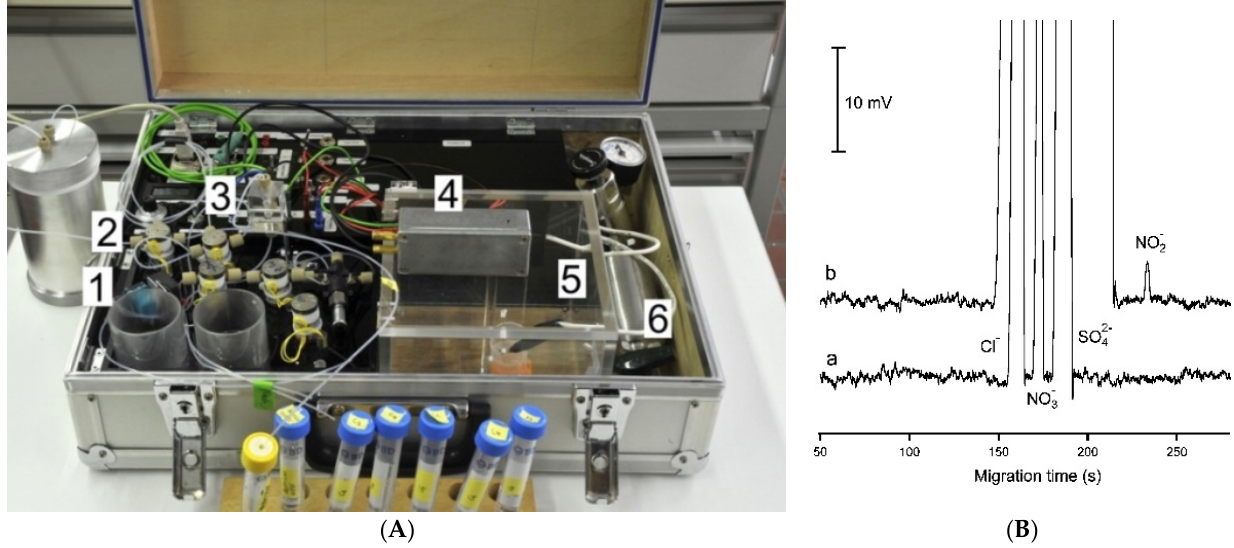
Figure 10. Photograph ( A ), and sample recording of an electropherogram applied in water analysis ( B ) of a laboratory-made portable capillary electrophoresis system with contactless conductivity detection [50]. In ( A ): (1) membrane pump, (2) valves, (3) splitter, (4) detector, (5) safety cage for application of high voltage, (6) pressurized air. In ( B ): recoding of the CE analysis of a tap water sample spiked with 1 µ M NO 2 − . (a) Normal injection volume: 1 bar, 150 µ L, splitting valve set to 0.15, 4 s. (b) Large volume injection: pressure, 1 bar; sample loop, 150 µ L; splitting valve set to 0.10; injection time, 10 s. CE conditions: capillary—60 (36) cm, 50 µ m I.D., BGE—12 mM His adjusted to pH 4 with AcOH, 2 mM of 18-crown-6, V: +15 kV. (Reproduced under permission from ACS).